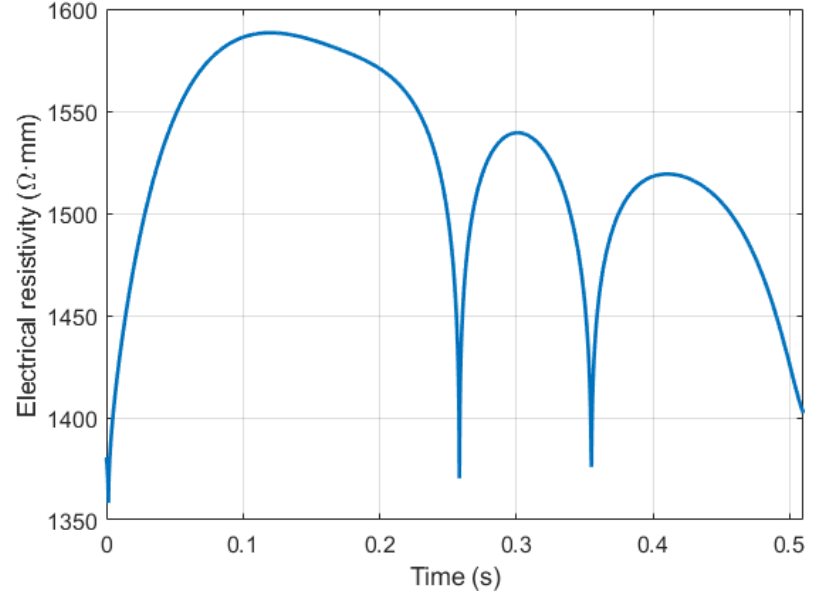
Figure 8. The blood resistivity change caused by red blood cells’ orientation effect.